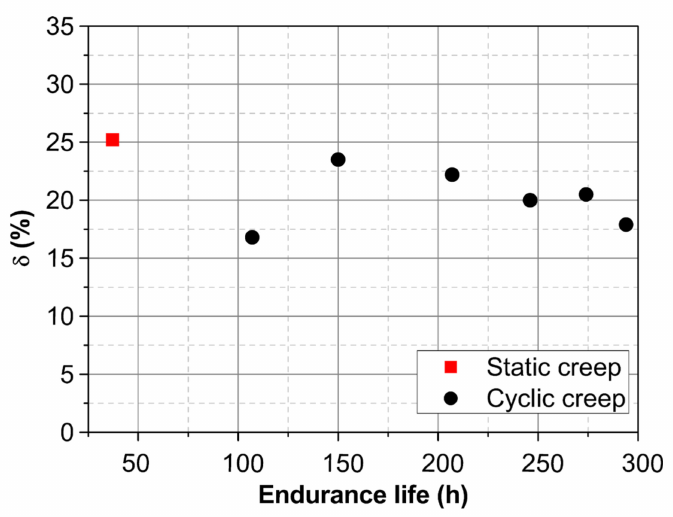
Figure 4. Fracture elongation of the specimen to the endurance